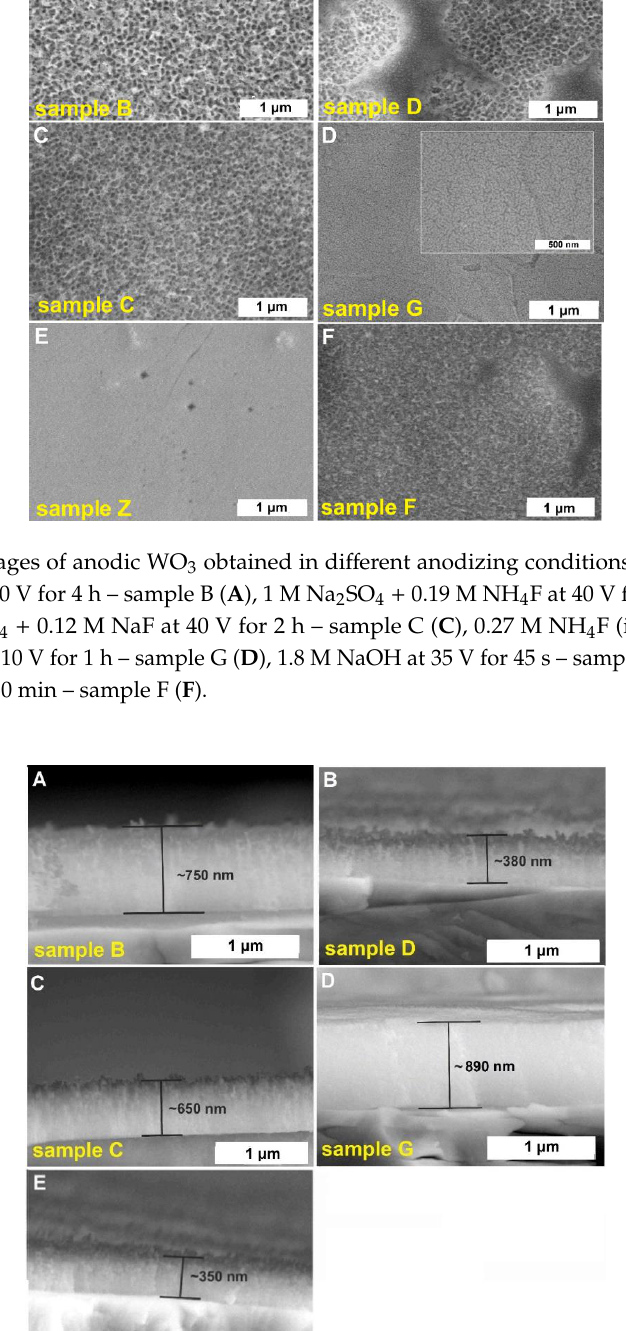
Figure 3. Current density vs. time curves recorded during anodic oxidation of metallic tungsten with marked different stages of anodization ( A ). Current density vs. time curves recorded during anodization of W at different conditions ( B ). Analyzing the typical shape of current density vs. time curves recorded during anodization, it can be seen that four characteristic stages can be distinguished (Figure 3A). At the beginning of electrochemical oxidation, the surface of tungsten is covered entirely with a compact oxide layer thickening with time by a field-assisted oxide growth, which is accompanied by a significant current